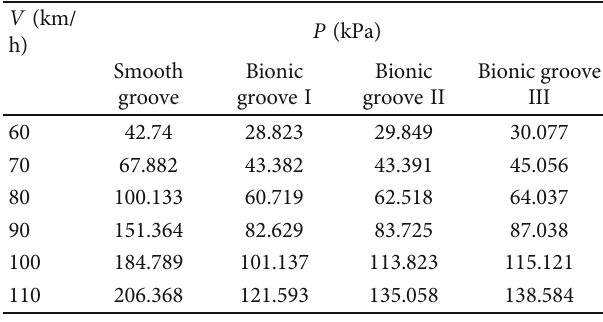
Figure 8: Bionic pattern groove model. (a) Calculation domain and (b) three bionic nonsmooth grooves. Table 3: Dynamic pressure at the bottom of grooves with di ff erent in fl ow speeds.